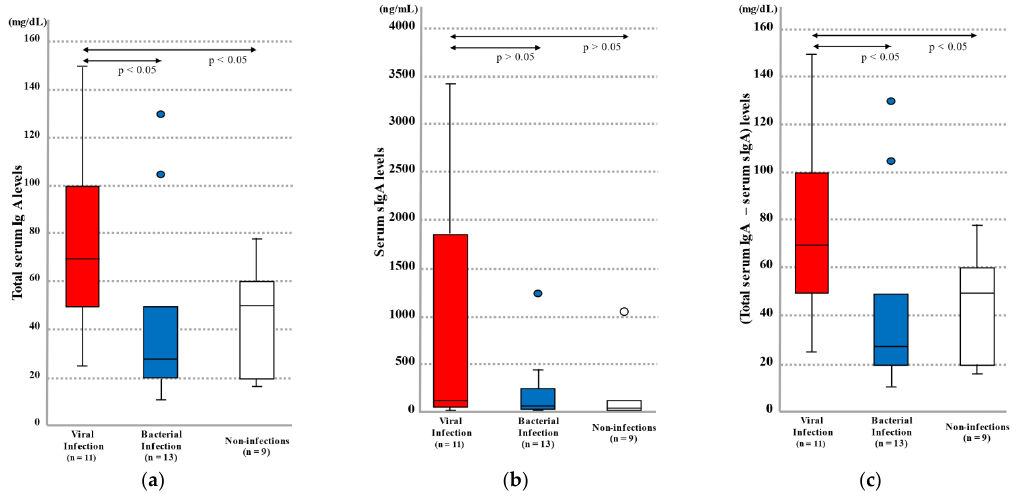
Figure 1. ( a ) Total serum IgA levels, ( b ) serum sIgA levels, and ( c ) total serum IgA levels–serum sIgA levels in autopsy cases by infection category. The lines in the graphs indicate median values and the lines above and below the boxes show 90% confidence intervals. The arrows indicate sig- nificant differences between two groups, at p < 0.05 according to the Mann–Whitney U test. Table 1. Total serum IgA levels, serum sIgA levels, and total serum IgA–serum sIgA levels by in- fection category.